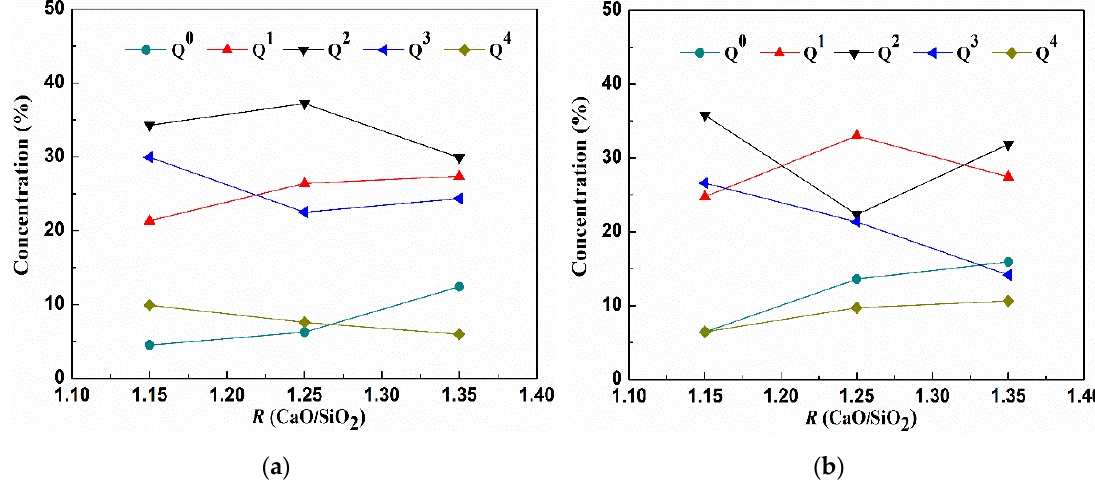
Figure 3. Effect of basicity on structure unit Q n ( a ) for Si ( b ) for B in CaO-SiO 2 -B 2 O 3 slag.